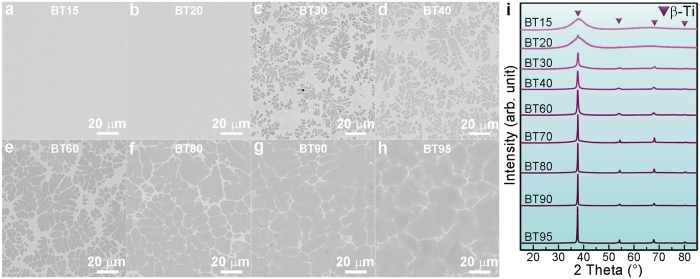
Characterization of as-cast BTX rods with a diameter of 10 mm.(a–h) The back-scattered scanning electron microscopy (SEM) micrographs of BT15, BT20, BT30, BT40, BT60, BT80, BT90, and BT95, respectively. BT15 shows a fully amorphous structure, and other samples have a two-phase microstructure. The growing intensities of the diffraction peaks (110) of β-Ti from BT20 to BT95 suggest an increasing volume fraction of β-Ti. (i) The X-ray diffraction patterns of BTX. The compositions of BTX are designed using the lever rule and calculated by equitation (5), as listed in Table 2. The designed mole fractions, x, of β-Ti have a strong influence on the final microstructure and the measured volume fractions of β-Ti are listed in Table 2.